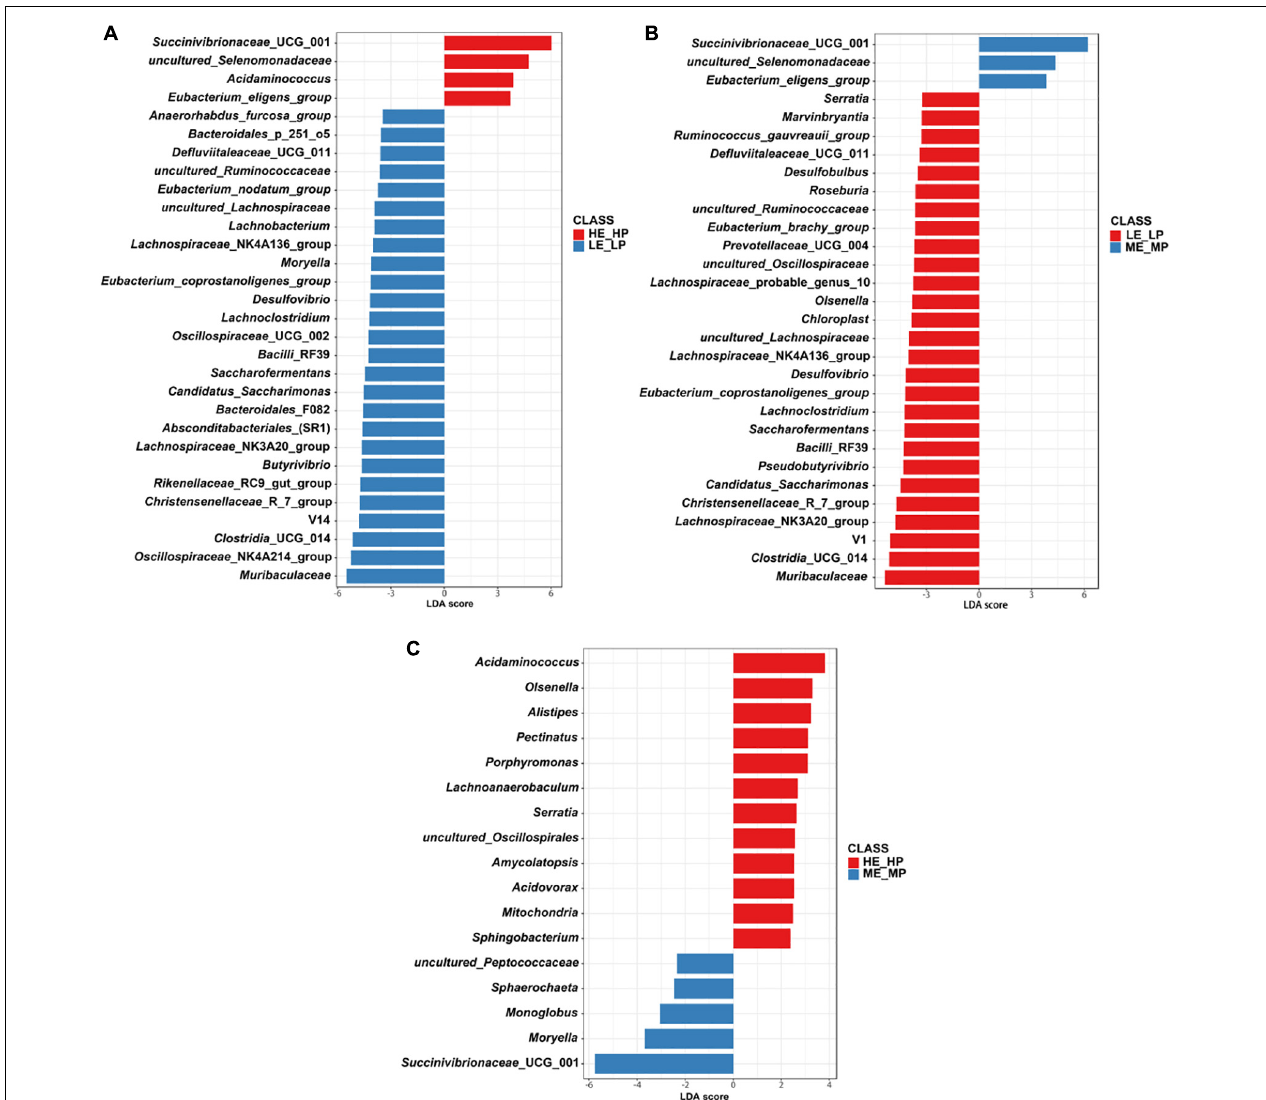
FIGURE 5 | Comparison of the relative abundances of rumen bacteria among the HE_HP cows, ME_MP cows, and LE_LP cows by linear discriminant analysis effect size ( P < 0.05; linear discriminant analysis, > 2). (A) Different rumen bacteria between HE_HP cows and LE_LP cows. (B) Different rumen bacteria between LE_LP cows and ME_MP cows. (C) Different rumen bacteria between HE_HP cows and ME_MP